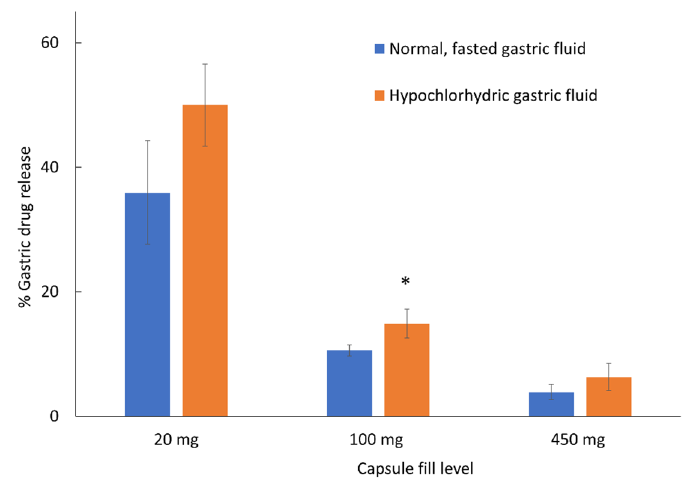
Figure 5. Acetaminophen release from Vcaps Enteric capsules with different fill levels after two-hour exposure to normal, fasted or hypochlorhydric, simulated gastric fluids. * Indicates significantly higher ( p < 0.05) premature gastric release under hypochlorhydic, simulated fluids compared to normal, fasted simulated gastric fluids. Data shown as drug release mean % ± SD.